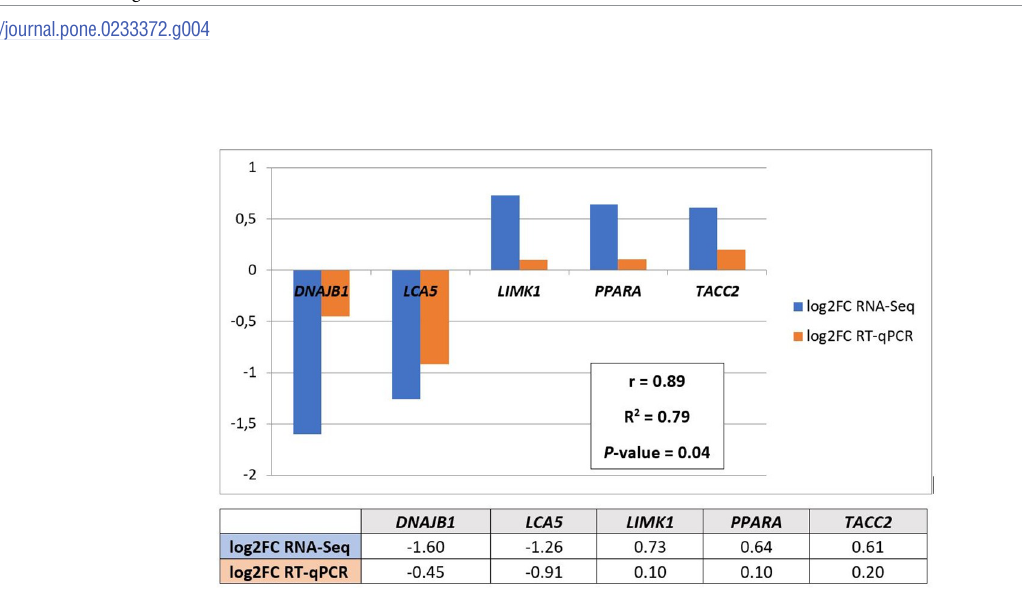
Fig 4. Results of the Gene Ontology (GO) analysis of the 58 differentially expressed genes (DEGs) associated with Intramuscular fat (IMF) deposition. The color and size of the dots show the significance and the ratio between the number of DEGs found in the present study belonging to the functional categories and the total number of genes in the functional categories.